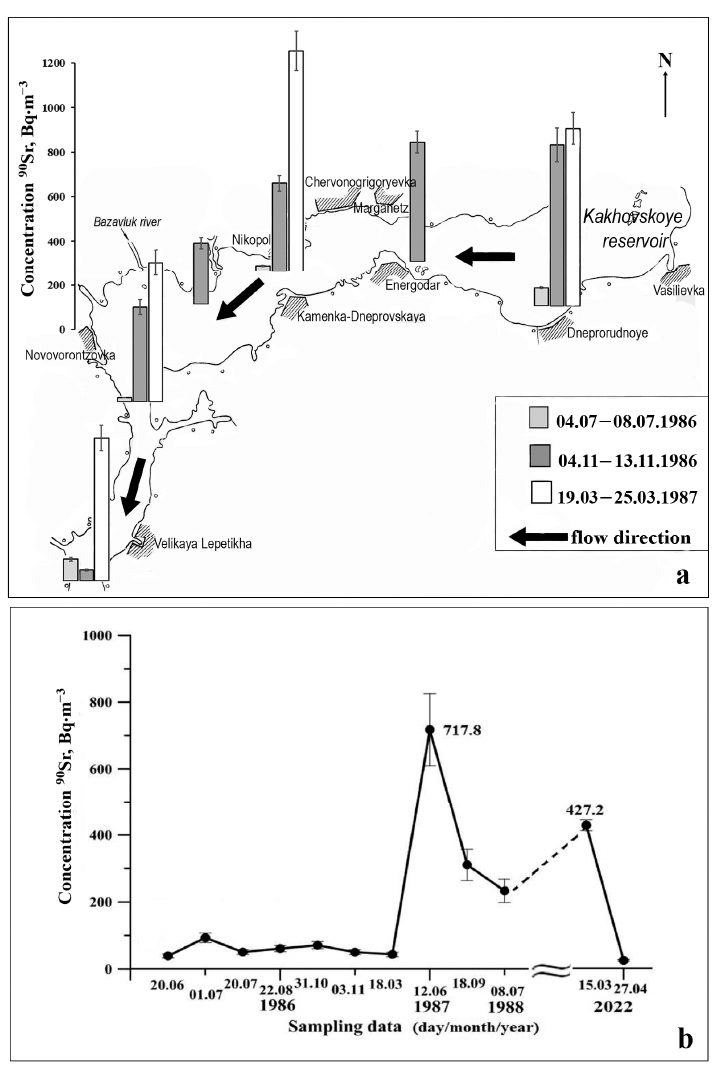
Figure 2. Dynamics of 90 Sr concentration in the Dnieper water in the NCC entry to the Crimean Peninsula (Armyansk) in 1986–1988 and 2022 ( b ) compared to 90 Sr input into the Kakhovskoye reservoir in 1986–1987 ( a ).